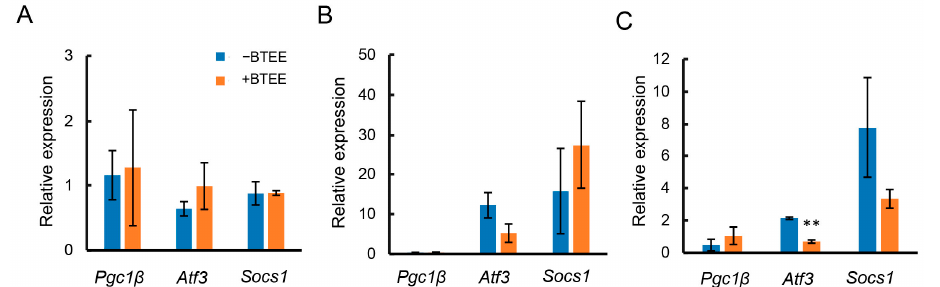
Figure 3. Effects of BTEE on the mRNA expressions of anti-inflammatory mediators. Cells were treated with or without BTEE at concentrations of 0.2 mg/mL for 24 h. After treatment, cells were stimulated with LPS (1 ng/mL) for ( A ) 0 h, ( B ) 6 h, and ( C ) 17 h. The mRNA expressions of pro- inflammatory mediators were determined by RT-PCR. Values are expressed as the mean ± SD of triplicate experiments. ** p < 0.01 significance compared to control samples.